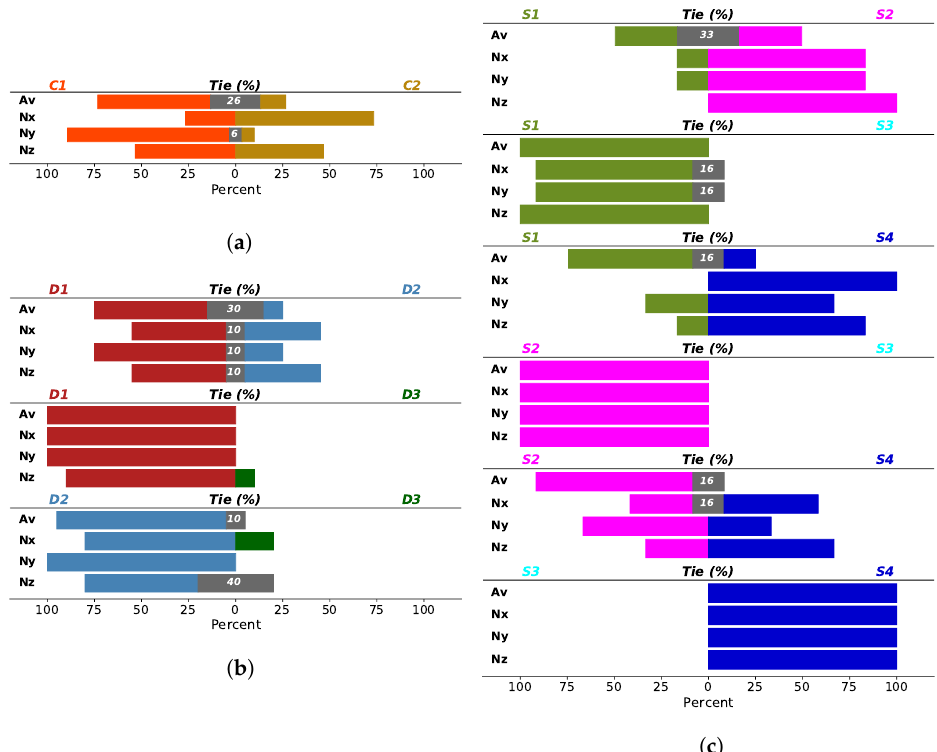
Figure 6. Comparison between drivers, cars and sections when A v , N x , N y , N z are considered. The percentages of situations where car i exceeds car j ( a ); driver i exceeds driver j ( b ); and section i exceeds section j ( c ) for each particular